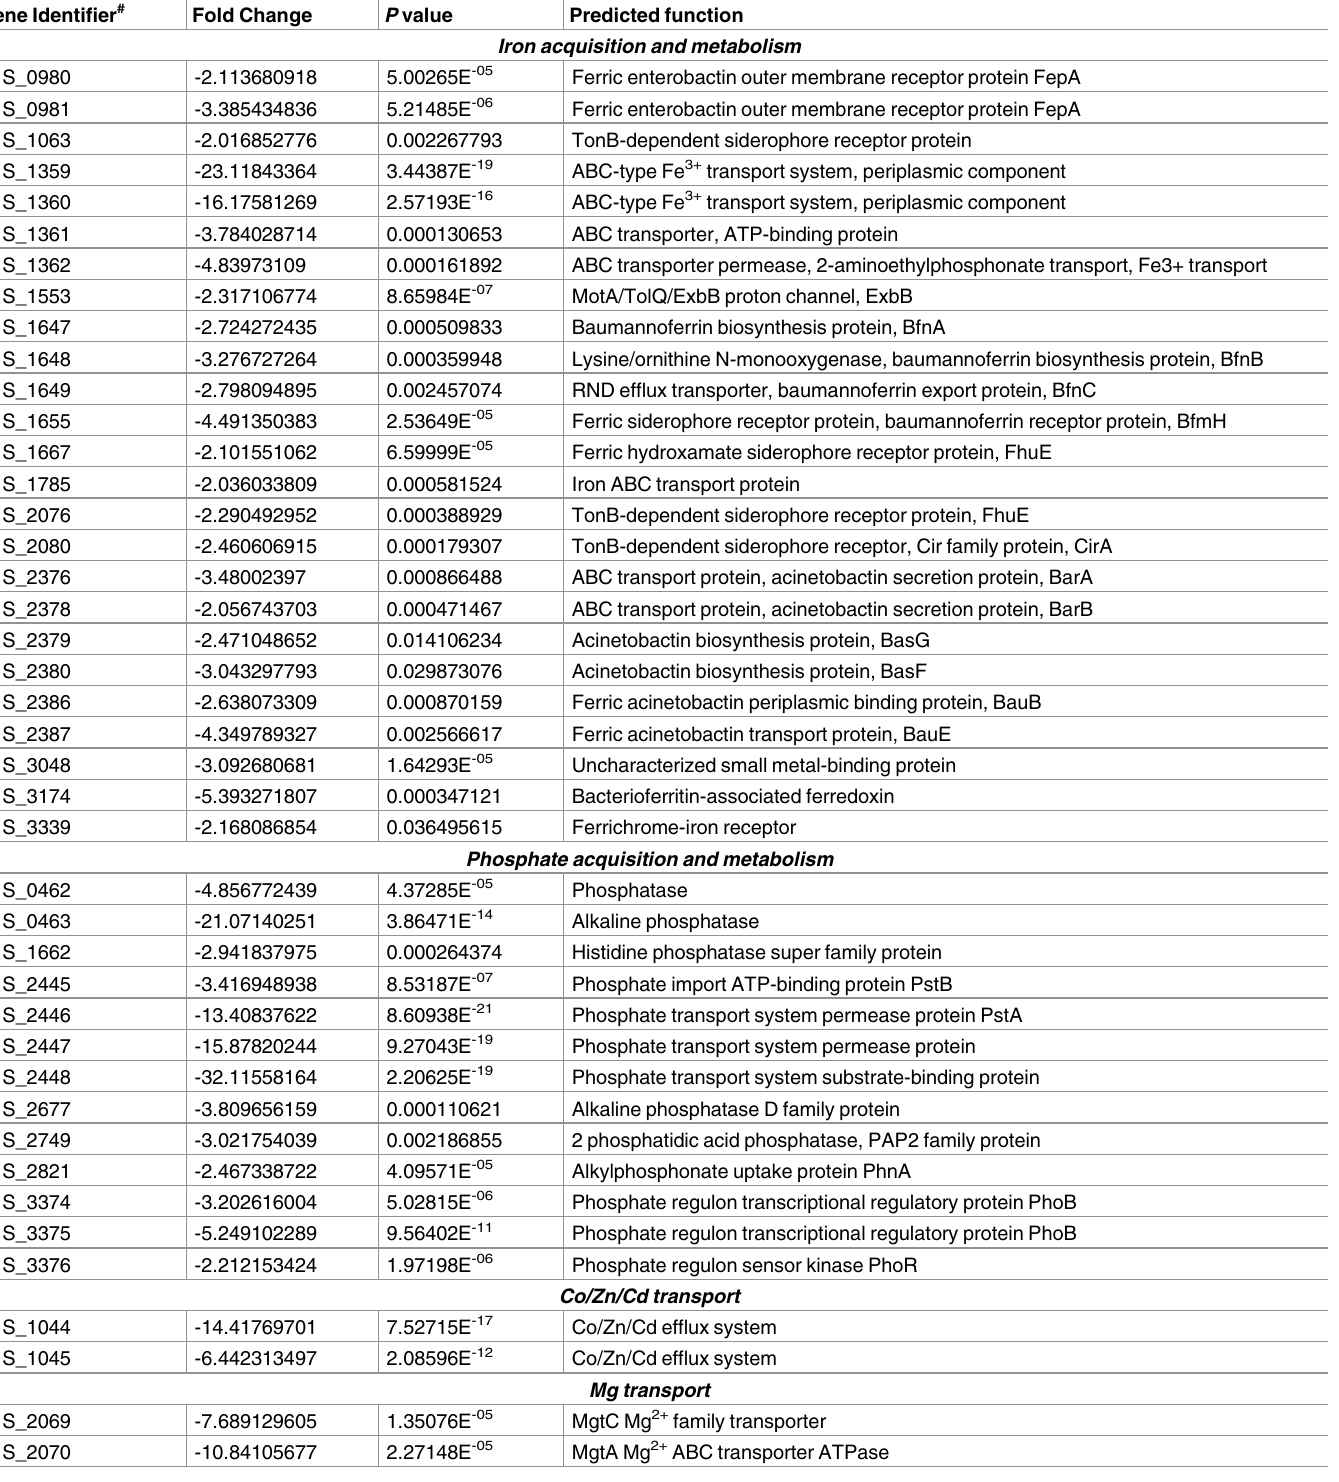
# Genes grouped together represent gene clusters transcribed in the same direction, some of which are potential polycistronic operons, and predicted to code for related